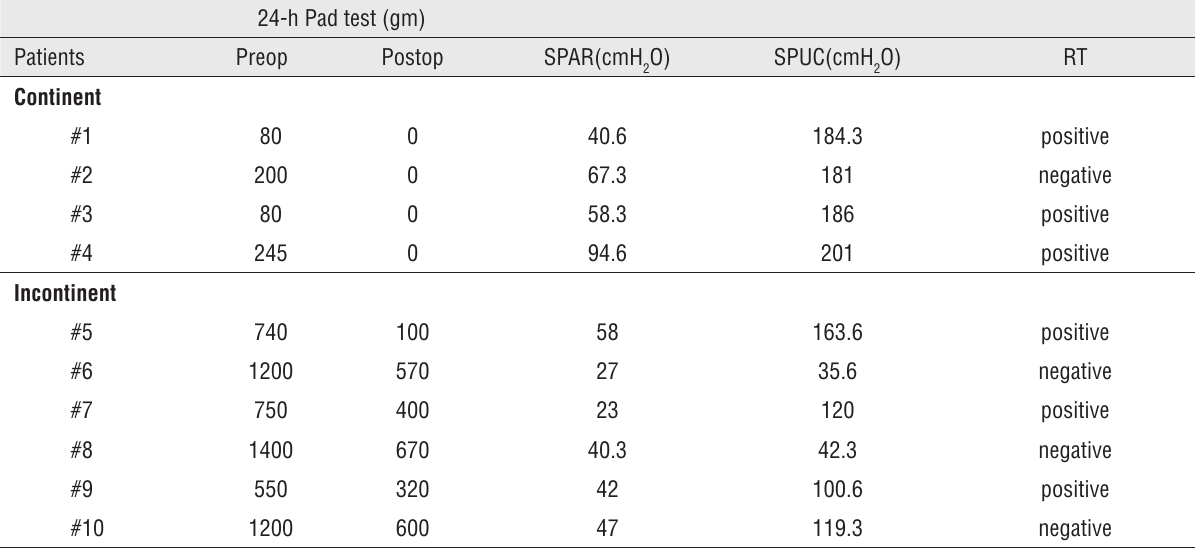
Table 1 - Pre and postoperative 24-h pad test, SPAR, SPUC and RT in postoperative continent and incontinent patients.